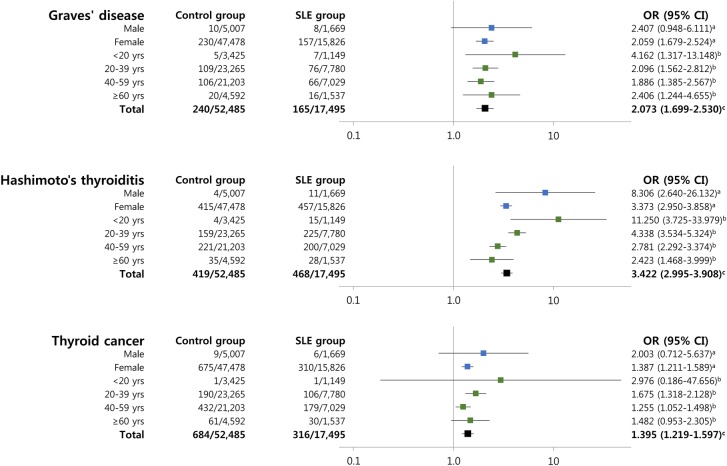
Analyses stratified according to age and sex for evaluating the association between SLE and thyroid disease.aAdjusted for age. bAdjusted for sex. cAdjusted for age and sex.